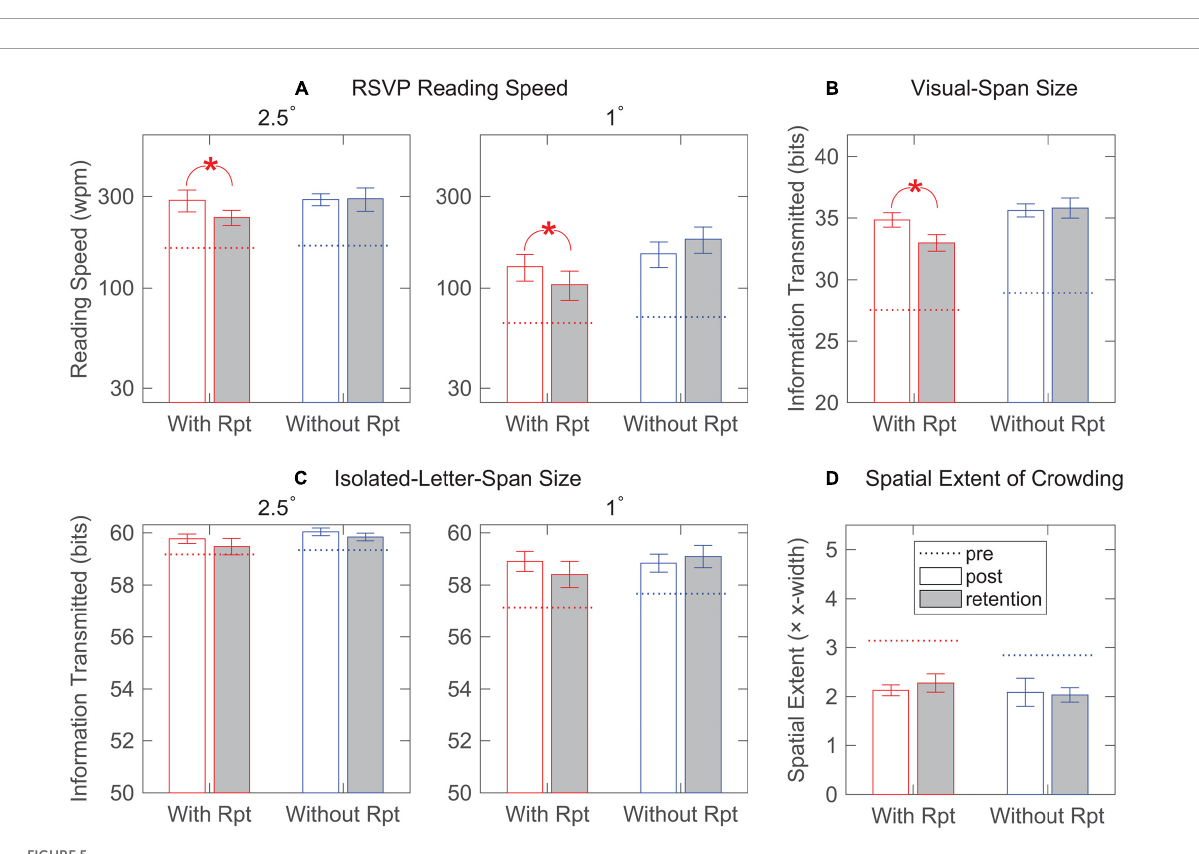
FIGURE5 Bar plots showing the group mean of post-test and retention-test performance for both the with-repetition and the without-repetition training groups. (A) Rapid Serial Visual Presentation (RSVP) reading speeds at 2.5 ◦ and 1 ◦ print sizes. The dotted lines represent the group means of pre-test performance. Error bars represent ± SEM. Asterisk (*) indicates a significant difference between post-test and retention-test performance. (B) The size of the visual span. (C) The size of the isolated-letter span at 2.5 ◦ and 1 ◦ print sizes. (D) Spatial extent of